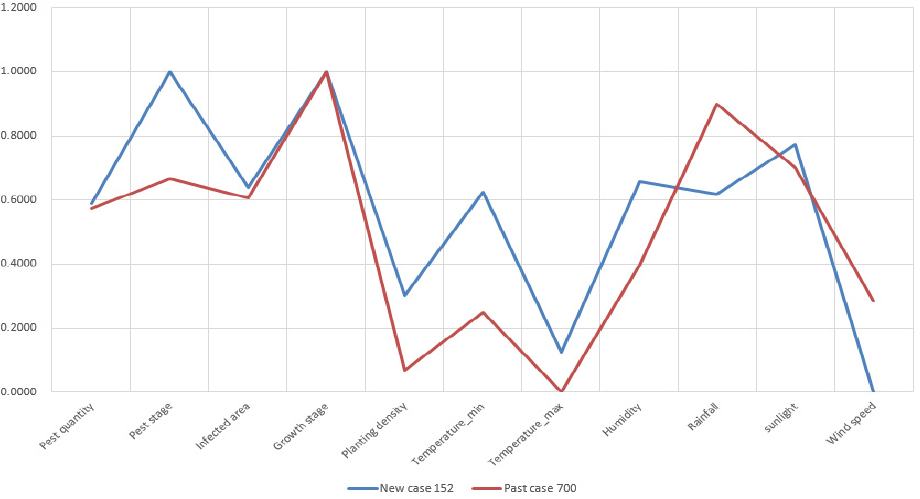
Figure A6. Attribute visualization of new case 151 and retrieved past case 611.